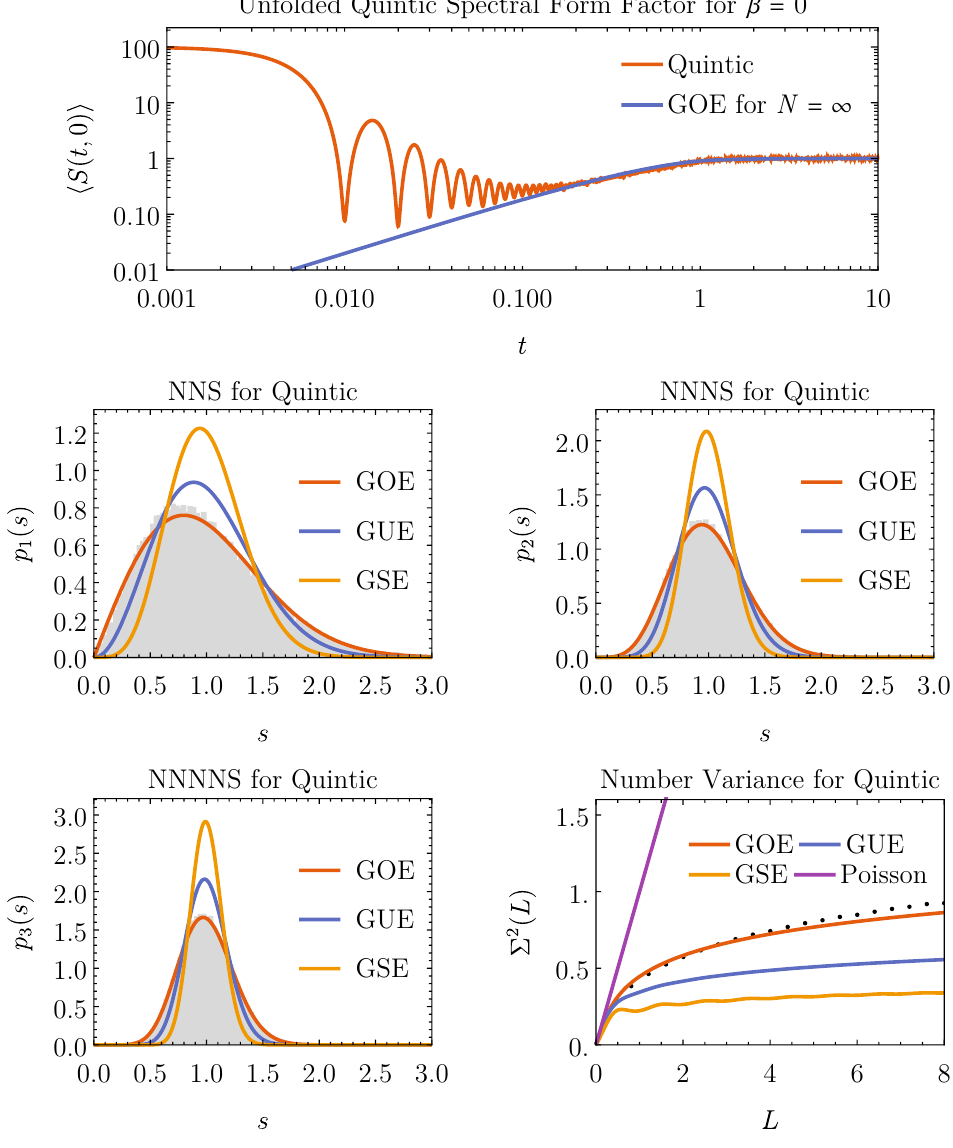
Figure 1 . The top row shows the unfolded spectral form factor for β = 0 for quintic Calabi-Yau threefolds. The orange curve shows an ensemble average consisting of 1,000 samples in complex structure moduli space with each sample containing the lowest-lying 100 eigenvalues. The dip, ramp and plateau are all present. The second and third rows display certain spectral statistics together with fits to GOE. (Other matrix ensembles are also shown for comparison.) The second row shows the nearest-neighbor level spacings (NNS) and the next-to-nearest (NNNS). The third row shows the next-to-next-to-nearest (NNNNS) level spacings and the number